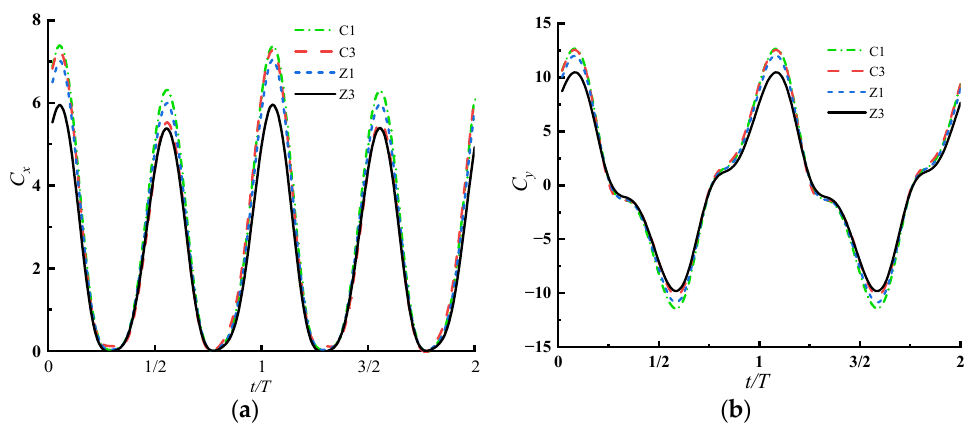
Figure 12. Variation of instantaneous thrust and lift coefficients with different passage structures: ( a ) Instantaneous thrust coefficients; ( b ) Instantaneous lift coefficients.